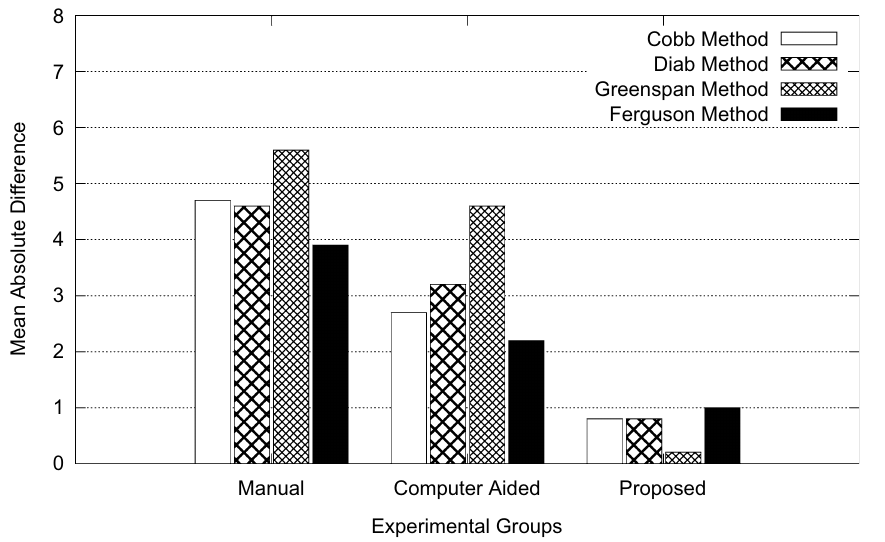
Figure 7. Type III (a) mean absolute difference (MAD) in inter observer variation.